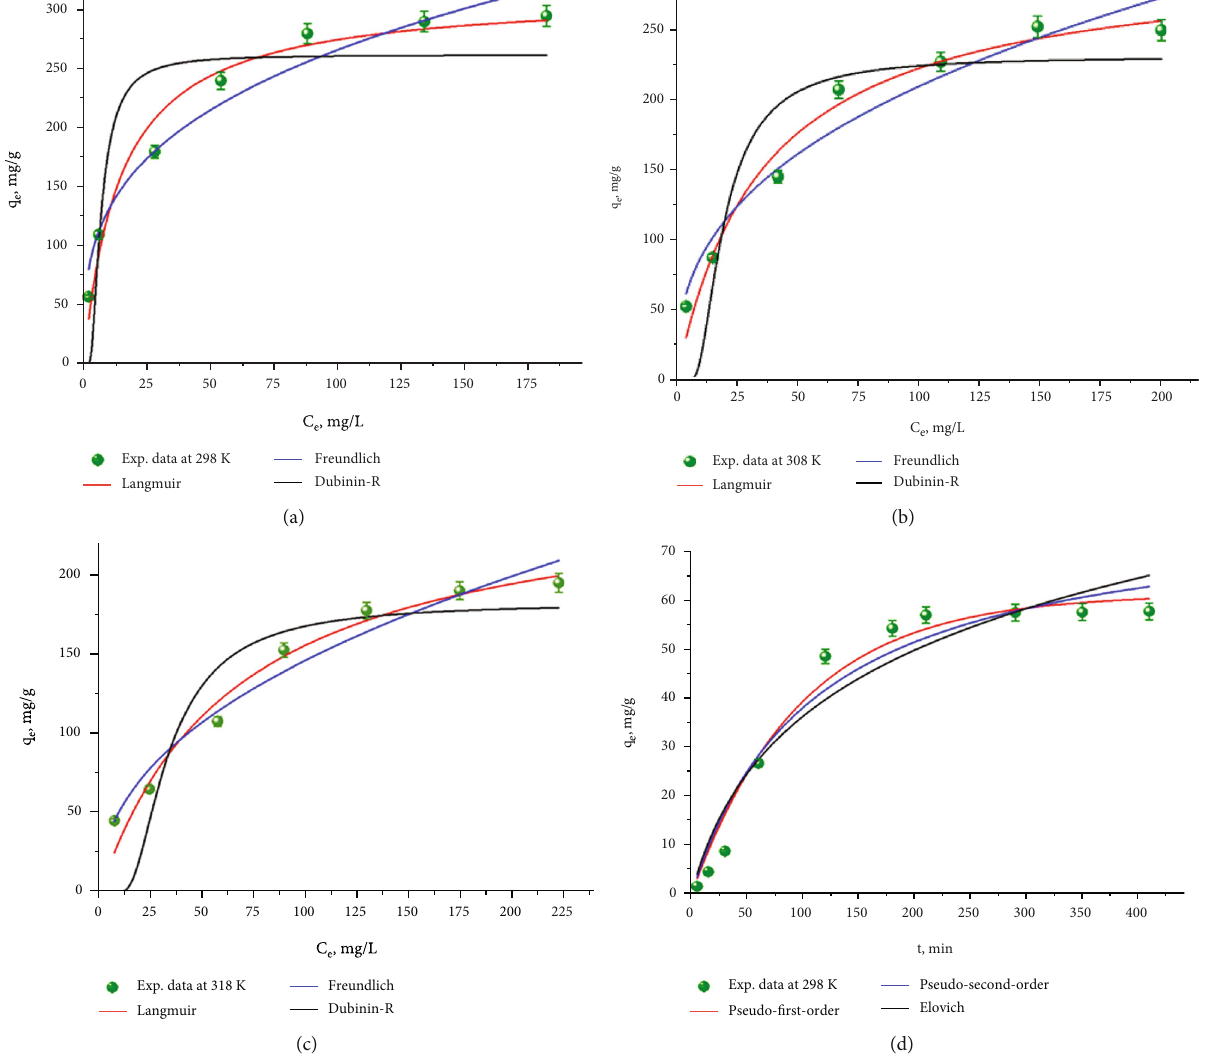
Figure 5: Adsorption isotherm fi t for the Cd(II) adsorption onto Fe 25-300 mg/L; adsorbent dose: 0.01g; agitation speed: 100rpm); adsorption kinetic fi t for the Cd(II) adsorption onto Fe (d) 298 K ( T : 298 K; C o : 25mg/L; adsorbent dose: 0.01 g; agitation speed: